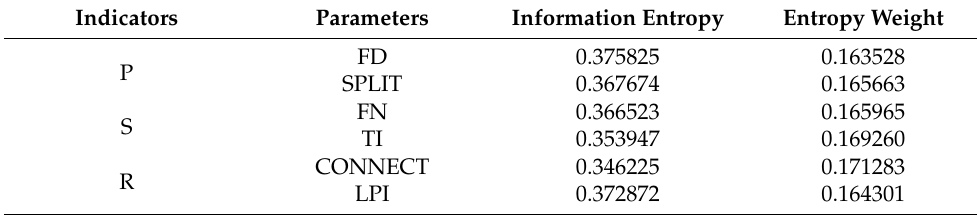
Table 5. The weight of EVI evaluation indicators.